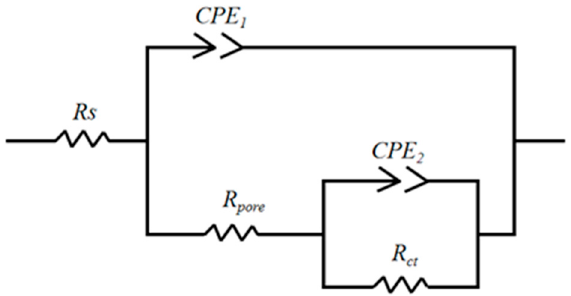
Figure 8. Nyquist diagrams of Cu-Ni-ZnO nanocomposite coatings with different (Cu, Ni)-ZnO additions.